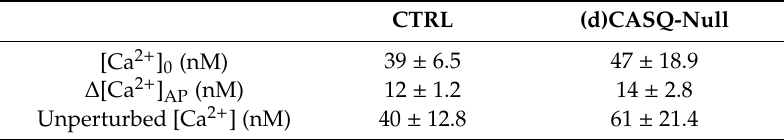
Table 2. Calcium parameters recorded in CA1 pyramidal neurons in CTRL and dCASQ-null mice.